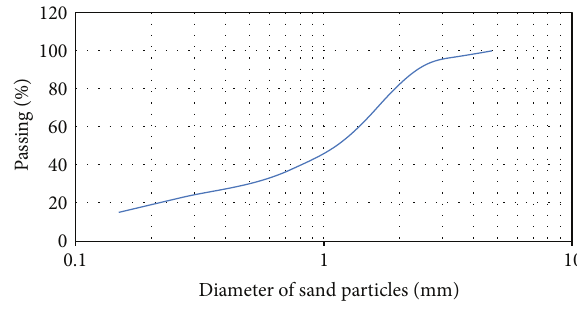
Figure 1: Grading curve of sand.